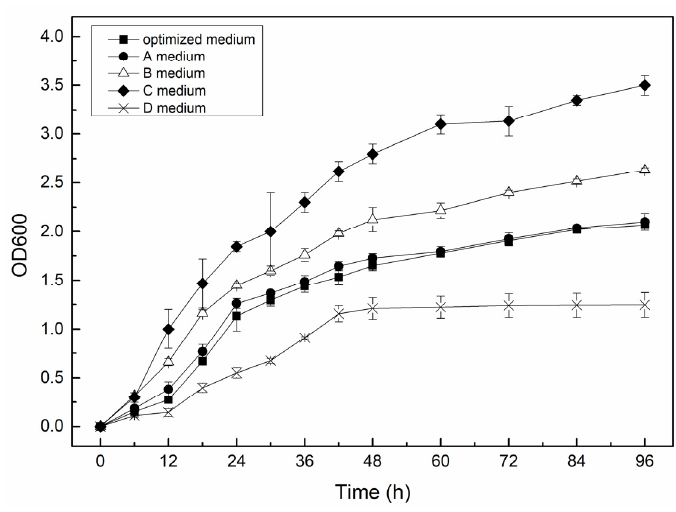
Figure 4. Growth curves over time for various media.